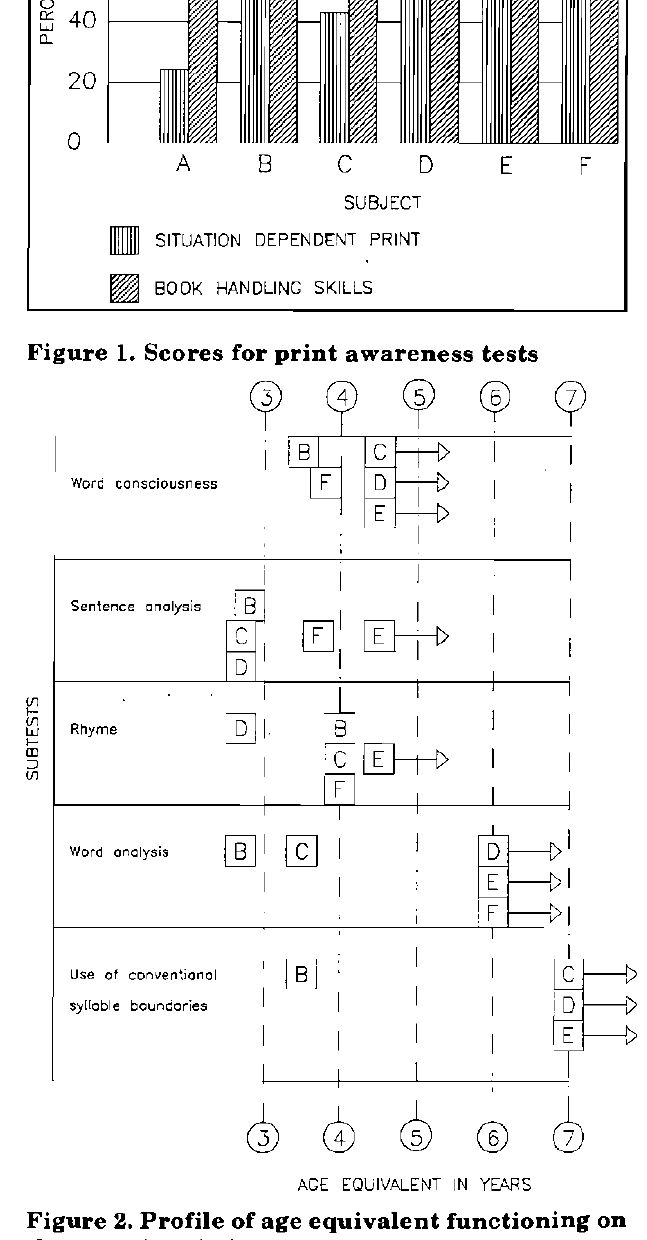
Figure 2. Profile of age equivalent functioning on the metalinguistic test